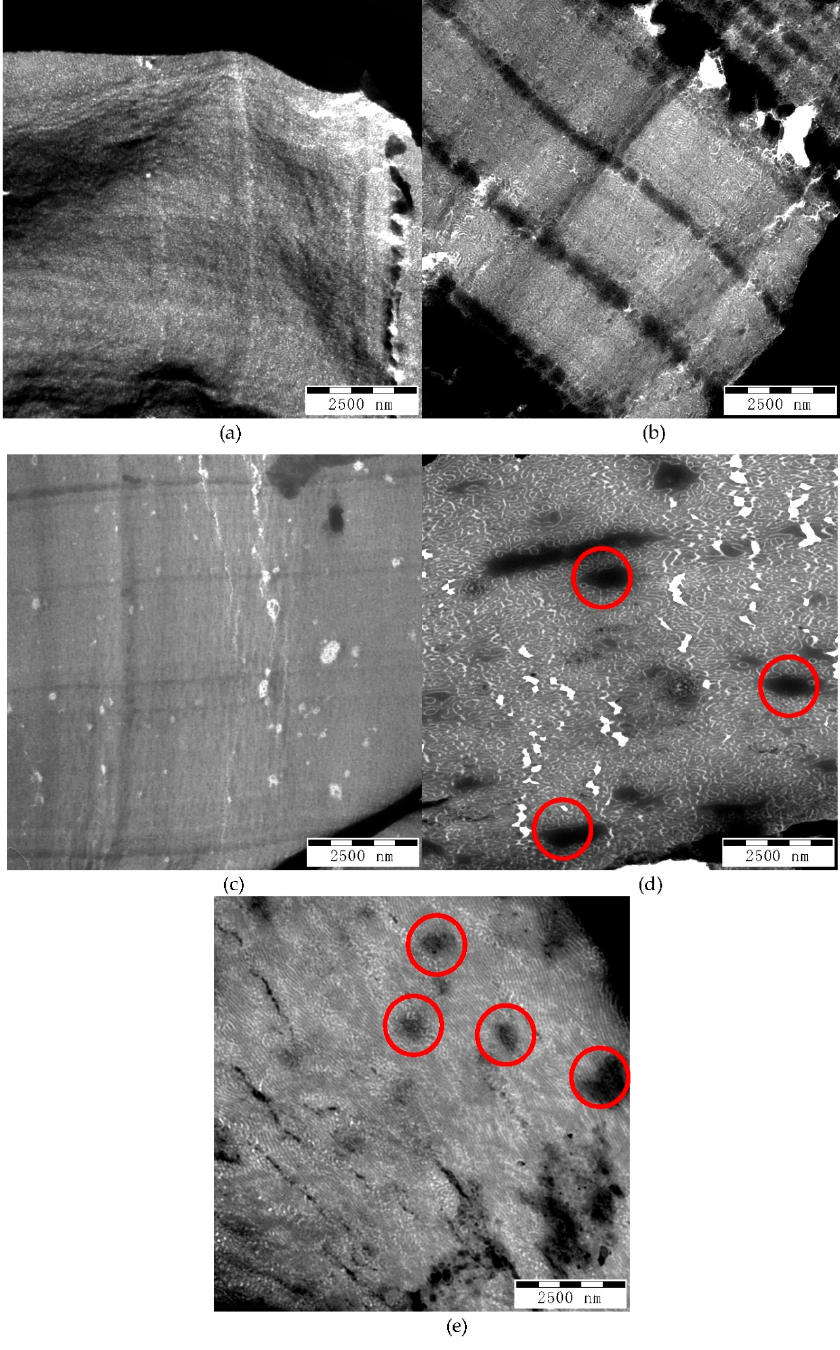
Figure 8. TEM pictures of blends at magnification 10,000×. ( a ) G-B GMA (52-4); ( b ) G-B GMA (104-4.1); ( c ) G-B GA (55-4.7); ( d ) G-B GA (98-4); ( e ) G-B GA (98-9.8). ( c ) G-B GA (55-4.7); ( d ) G-B GA (98-4); ( e ) G-B GA